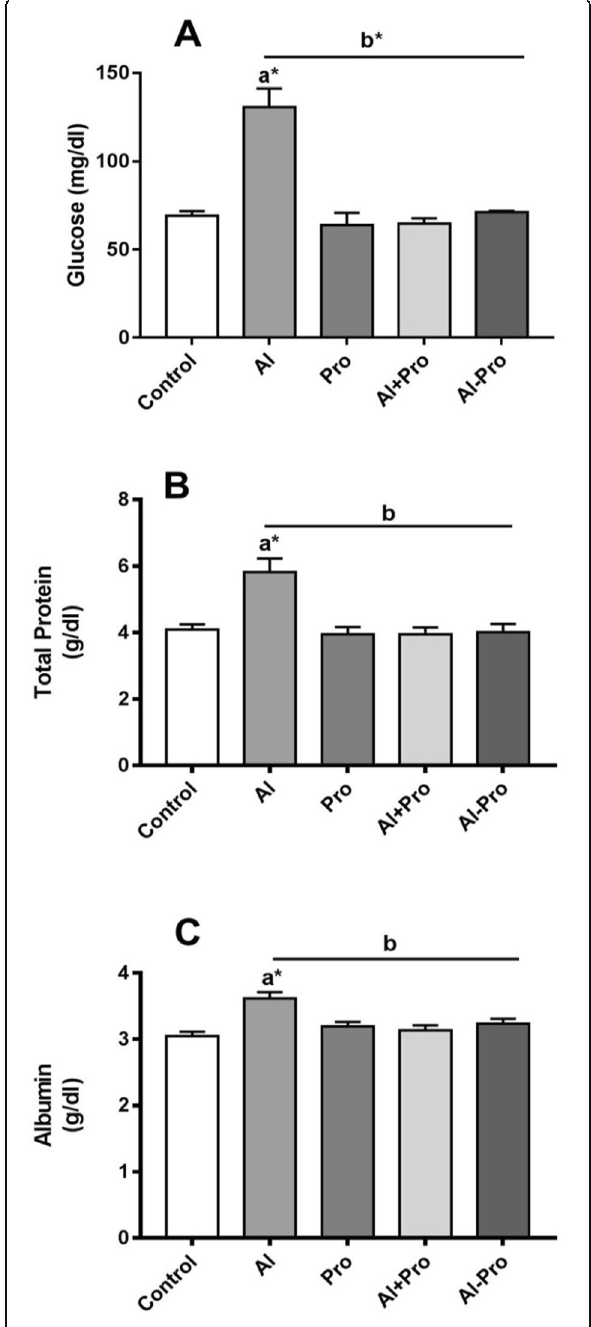
Fig. 2 Effect of propolis for two months on the level of glucose ( A ), total protein ( B ), and albumin ( C ) in rats treated with AlCl3. Significance (a): relative to the control group. Significance (b): relative to the AlC13 group. Significance: P < 0.05, highly significance (*): P <